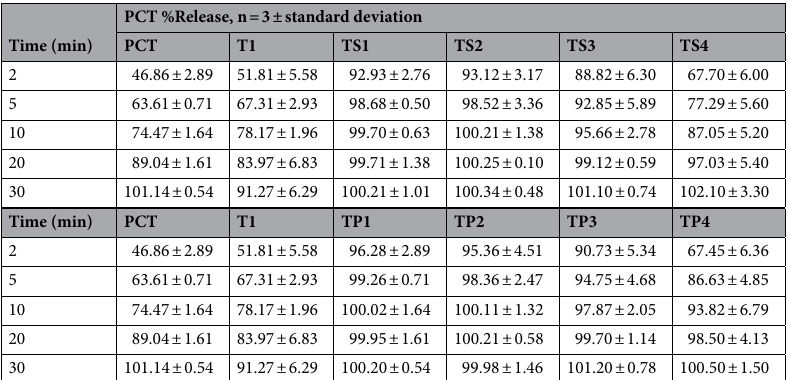
Table 3. Dissolution %Release data of PCT in 0.1 N HCl medium.